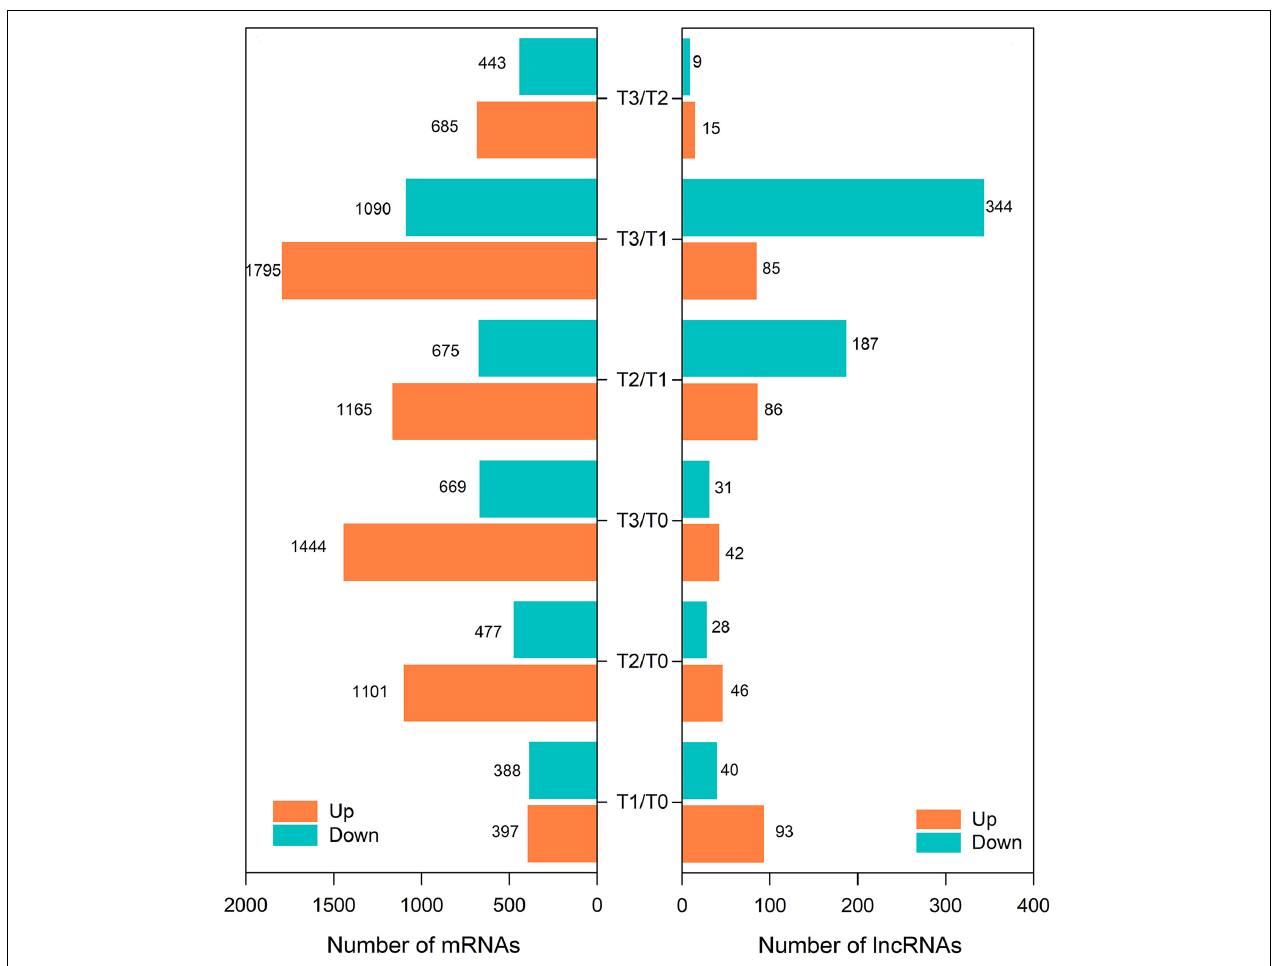
FIGURE 3 | The number of differentially expressed mRNAs and lncRNAs in wheat seedlings after